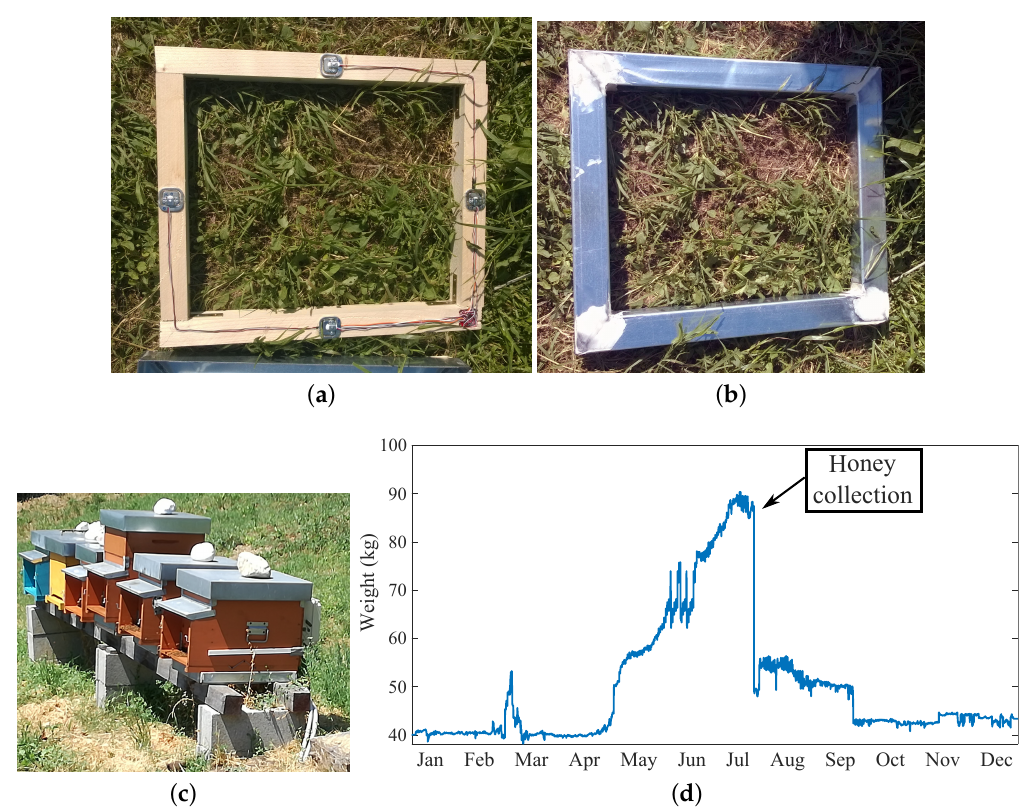
Figure 3. Implementation of the weight measurement system: ( a ) load cells installation, ( b ) aluminum covering frame, ( c ) weight measurement system installation under each hive within the bee colony, positioned in the University campus, and ( d ) weight measurements collected during 1